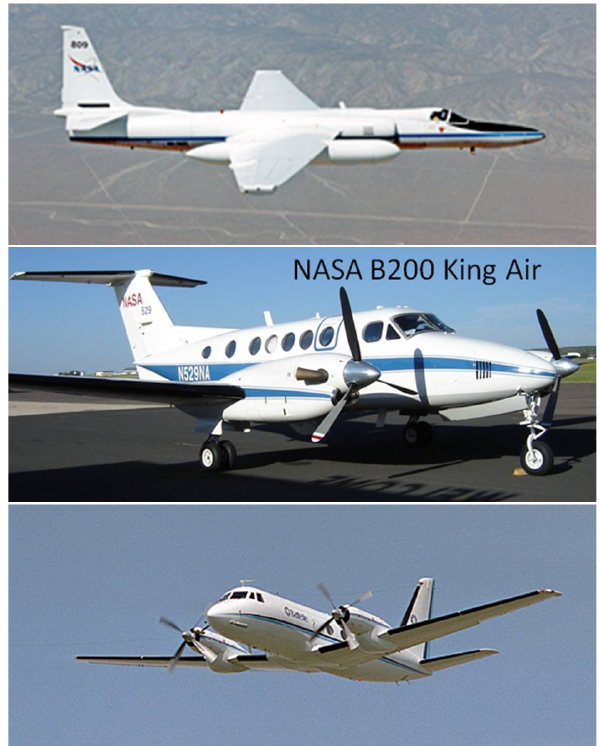
Fig. 2. Photos of the NASA ER-2, NASA Langley B200 King Air, and US DOE G-1. Images are ordered according to the flight al- titude used during the CLASIC and CHAPS campaigns, with the ER-2 flying the highest of the three